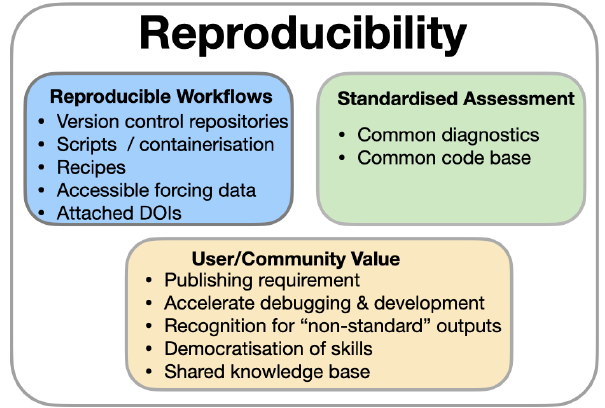
Figure 1. The principle of reproducibility is delivered by repro- ducible workflows and standardised assessment, but this ideal can only be maintained when its contribution is understood and